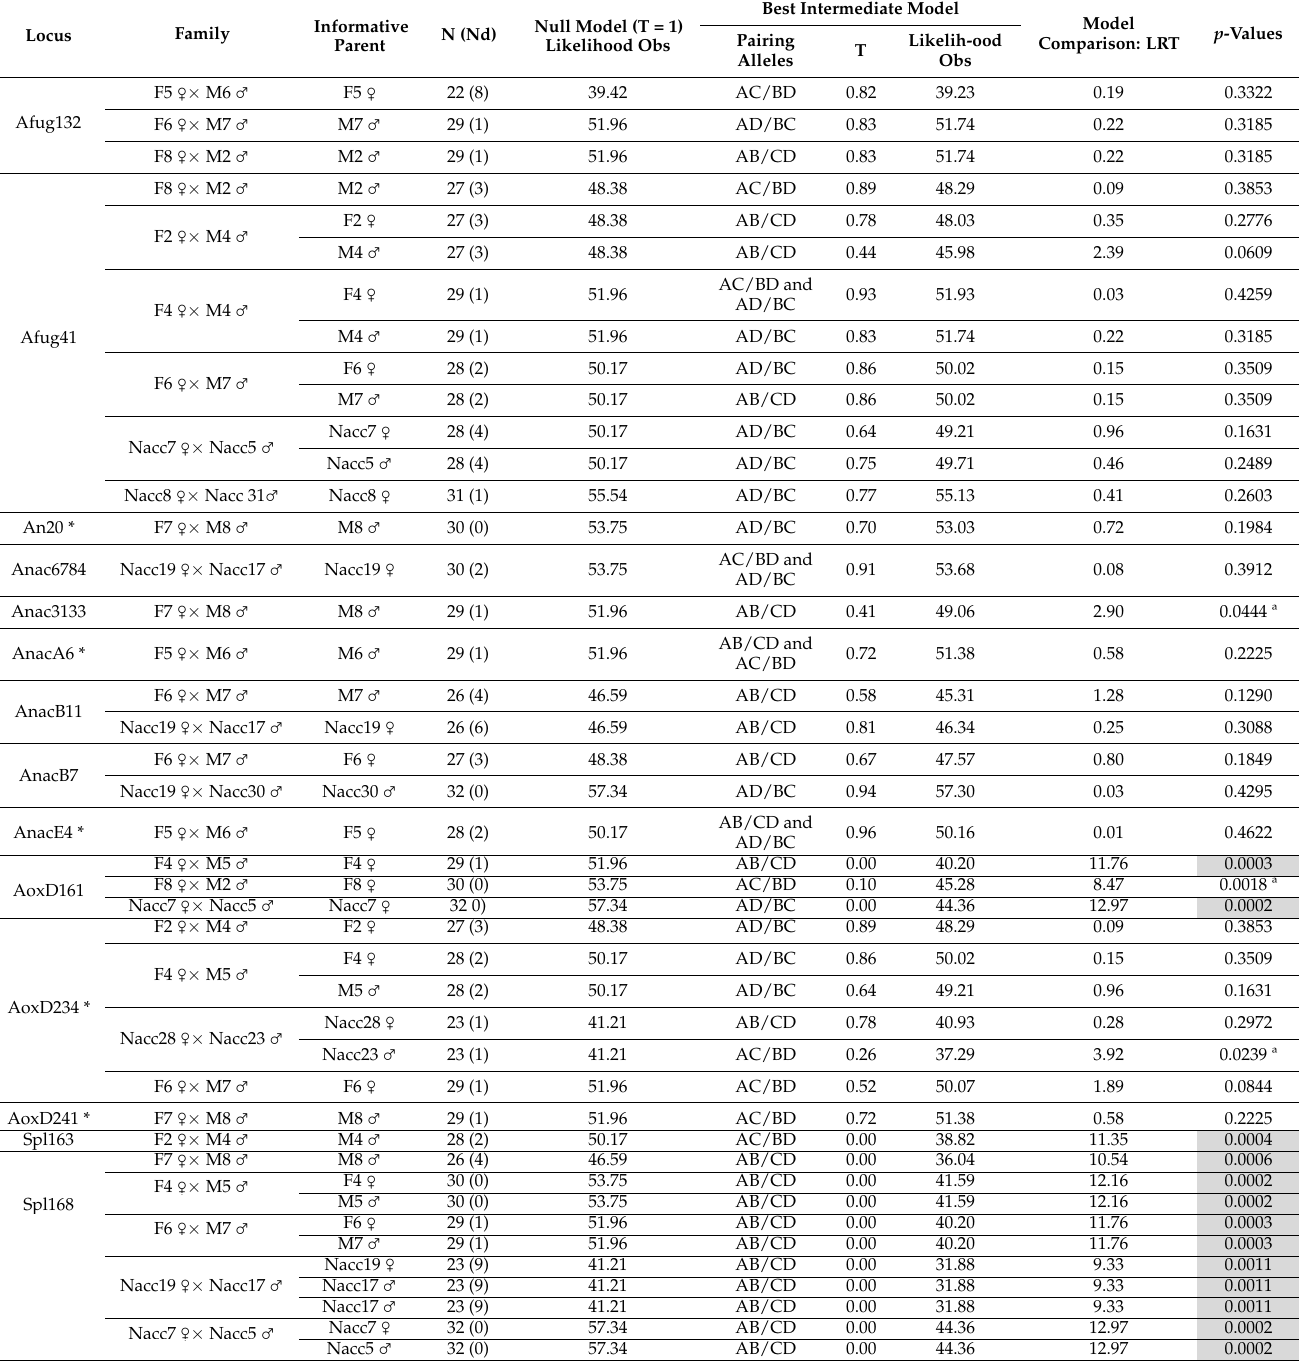
Table 2. Likelihood Ratio